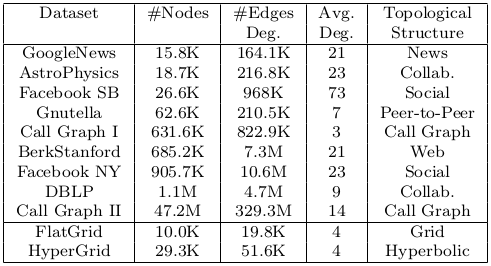
Table from the paper: A Geometric Distance Oracle for Large Real-World Graphs
Table text:
Dataset
#Nodes
#Edges
Avg.
Topological
Deg.
Deg.
Structure
GoogleNews
15.8K
164.1K
21
News
AstroPhysics
18.7K
216.8K
23
Collab.
FacebookSB
26.6K
968K
73
Social
Gnutella
62.6K
210.5K
7
Peer-to-Peer
CallGraphI
631.6K
822.9K
3
CallGraph
BerkStanford
685.2K
7.3M
21
Web
FacebookNY
905.7K
10.6M
23
Social
DBLP
1.1M
4.7M
9
Collab.
CallGraphII
47.2M
329.3M
14
CallGraph
FlatGrid
10.0K
19.8K
4
Grid
HyperGrid
29.3K
51.6K
4
Hyperbolic